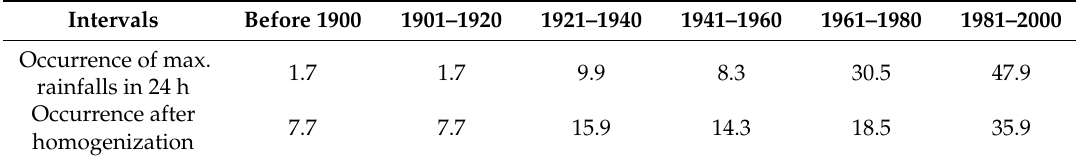
Table 5. Variations in max. rainfall occurrence, exceeding 100 mm/24 h, within the past century. Intervals